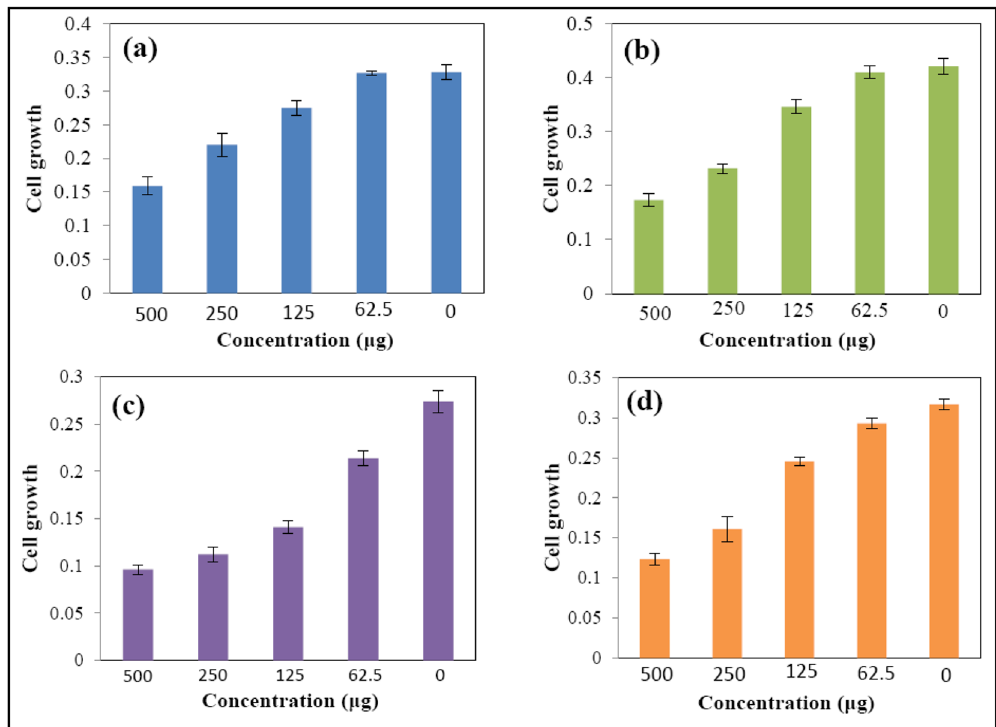
Figure 14. The cytotoxicity images of the nanocomposites with eror bar of the average growth of cells for the most effective cells of HT29 for the CdS@HPEc-g-PANi at 48 h ( a ) and 72 h ( b ) and PC3 for the mCdS@HPEc- g-PANi nanocomposite at 48 h ( c ) and 72 h ( d